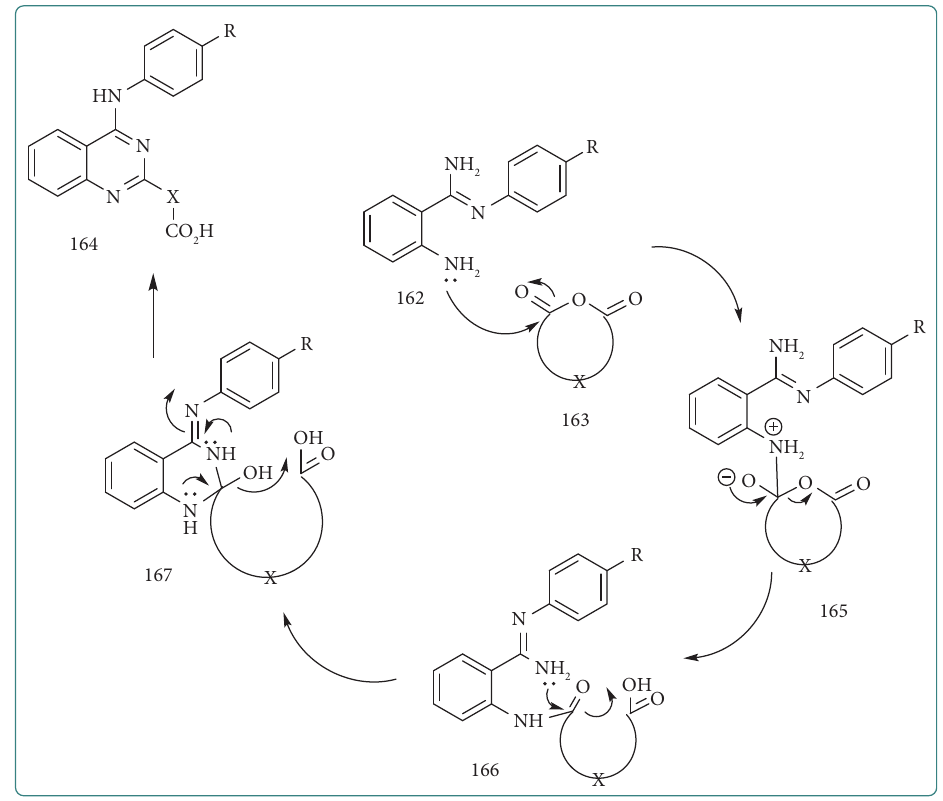
Figure 17: Te proposed mechanism for the synthesis of 4-arylaminoquinazoline-2-carboxylic acid